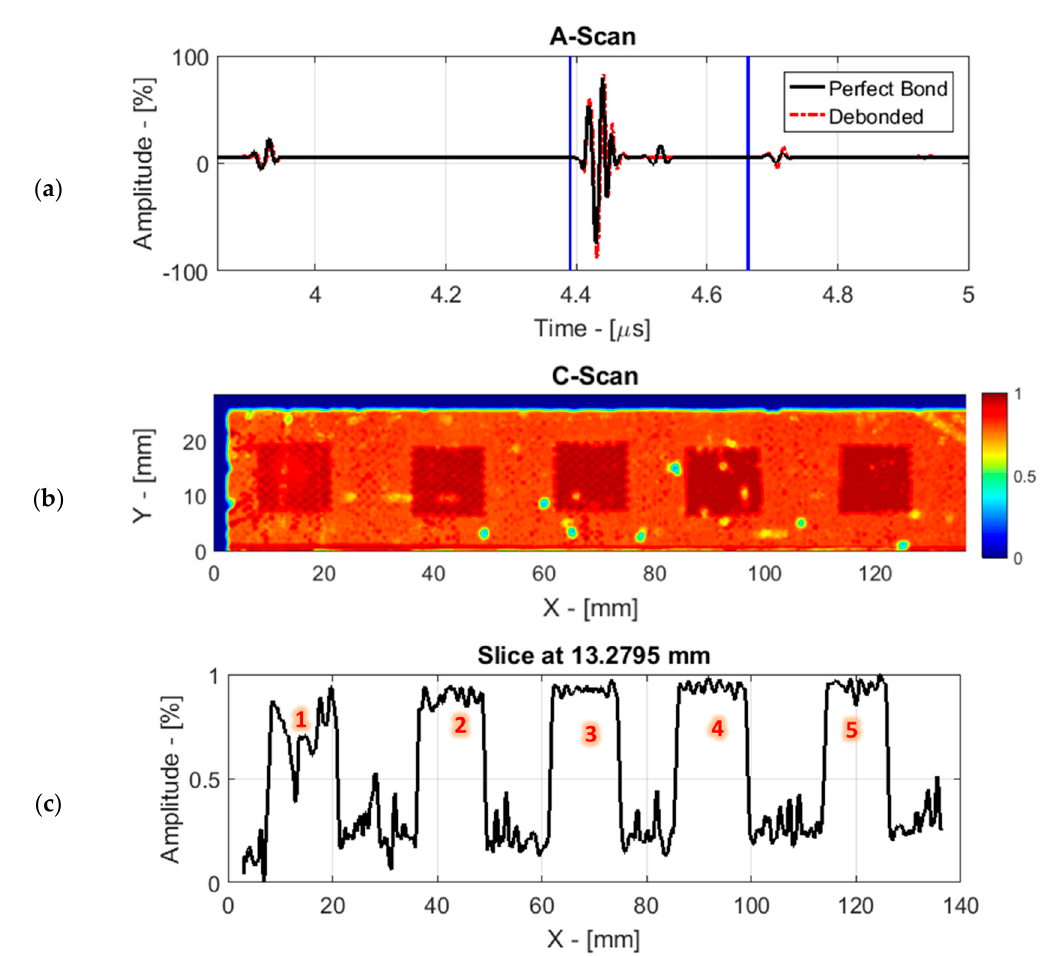
Figure 13. Scanning acoustic microscopy (SAM) results for debonded sample: ( a ) A-scan; ( b ) C-scan; ( c ) slice from the middle of the defects.